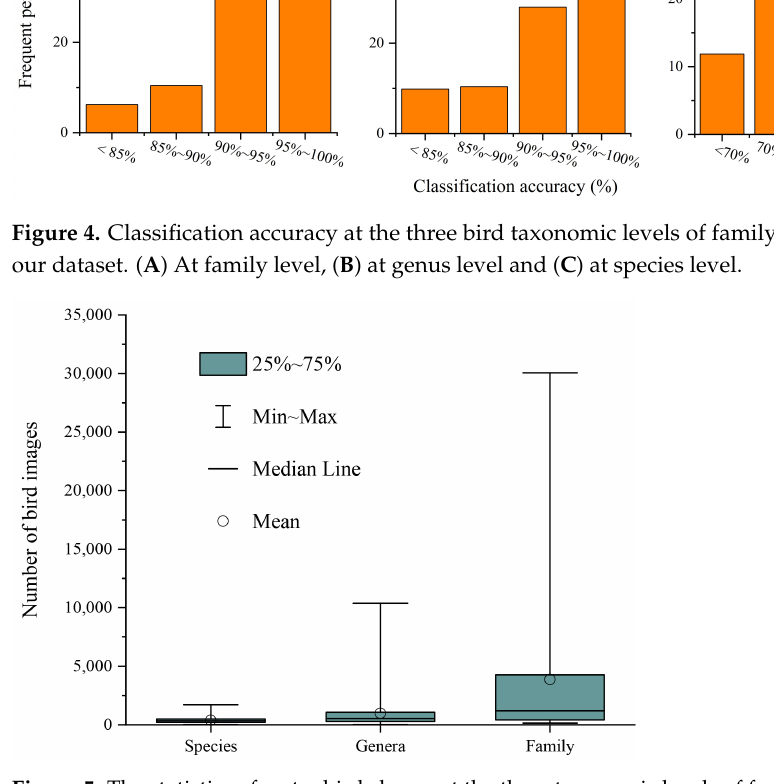
Figure 5. The statistics of water bird classes at the three taxonomic levels of family, genus and species in our